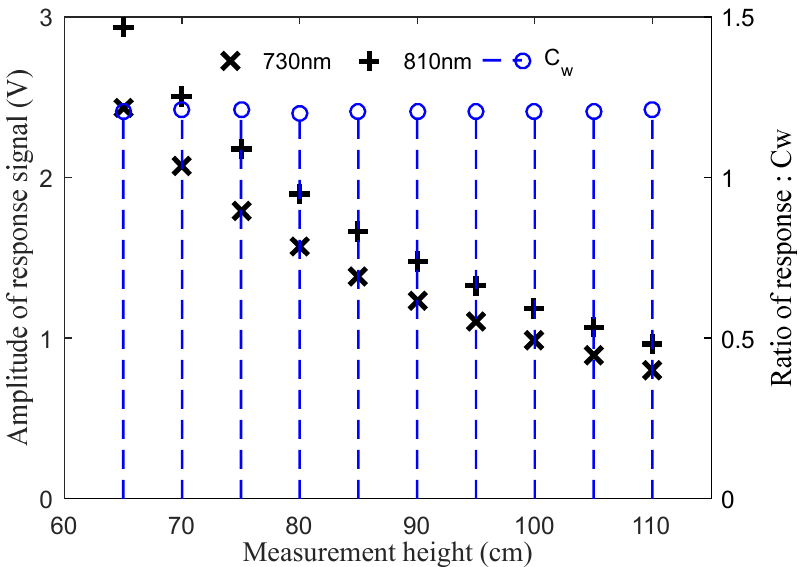
ff erent measurement Figure 13. The measured value of C W indoors at different measurement heights. Figure 13. The measured value of C W indoors at di Figure 13. The measured value of C W indoors at different measurement heights.